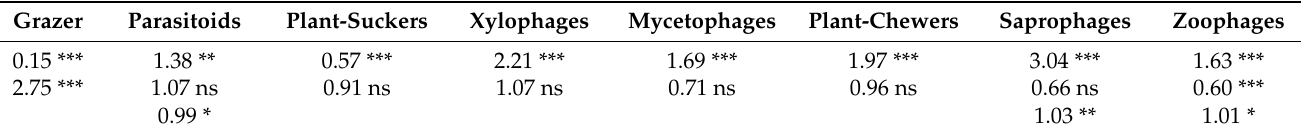
Table 1. Results of modelling guild composition by logistic regression of 77 Quercus trees in Bialowieza in 2001 and 2002, in primary and managed forests, adjusted for leaf cover. Variables deleted by model test are displayed by white boxes. Numbers indicate odds ratios of the associated coefficients, while the stars indicate the adjusted significance levels. The factor Year compares guild composition between year 2002 and year 2001, while Management compares primary sites and managed